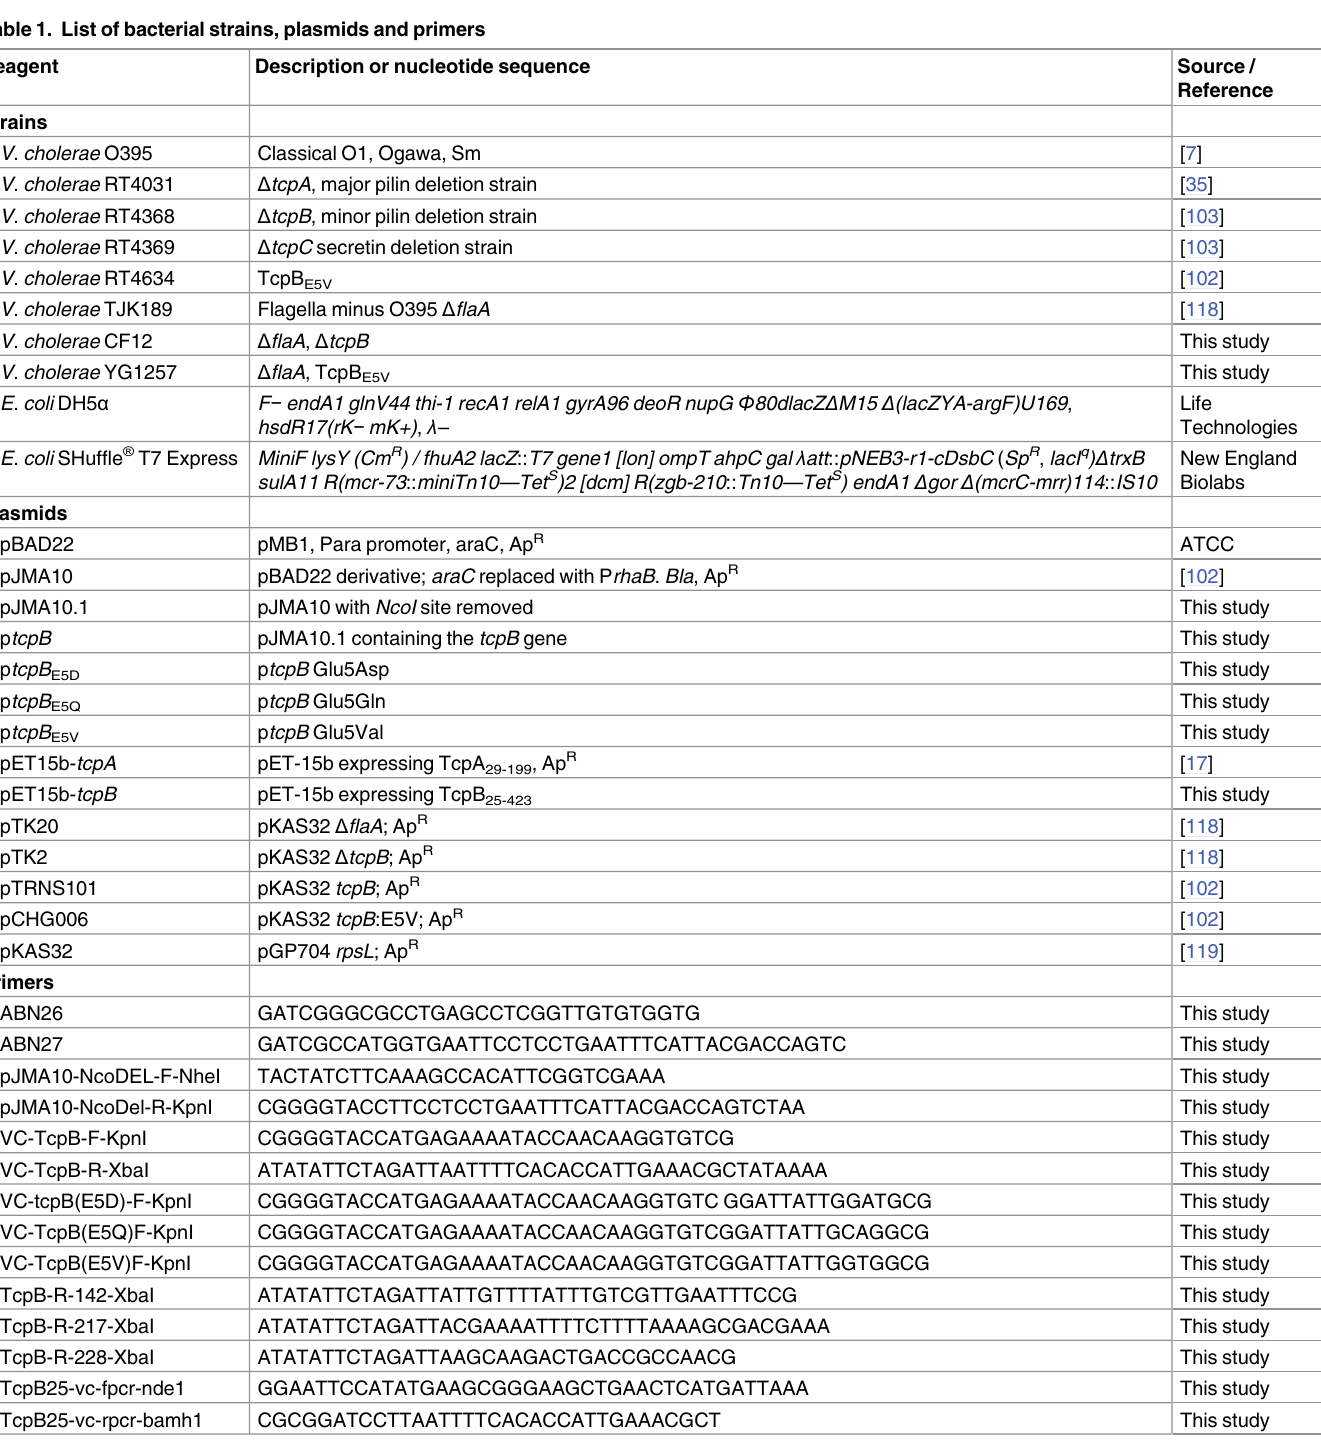
Table 1. List of bacterial strains, plasmids and primers Reagent Description or nucleotide sequence Source /